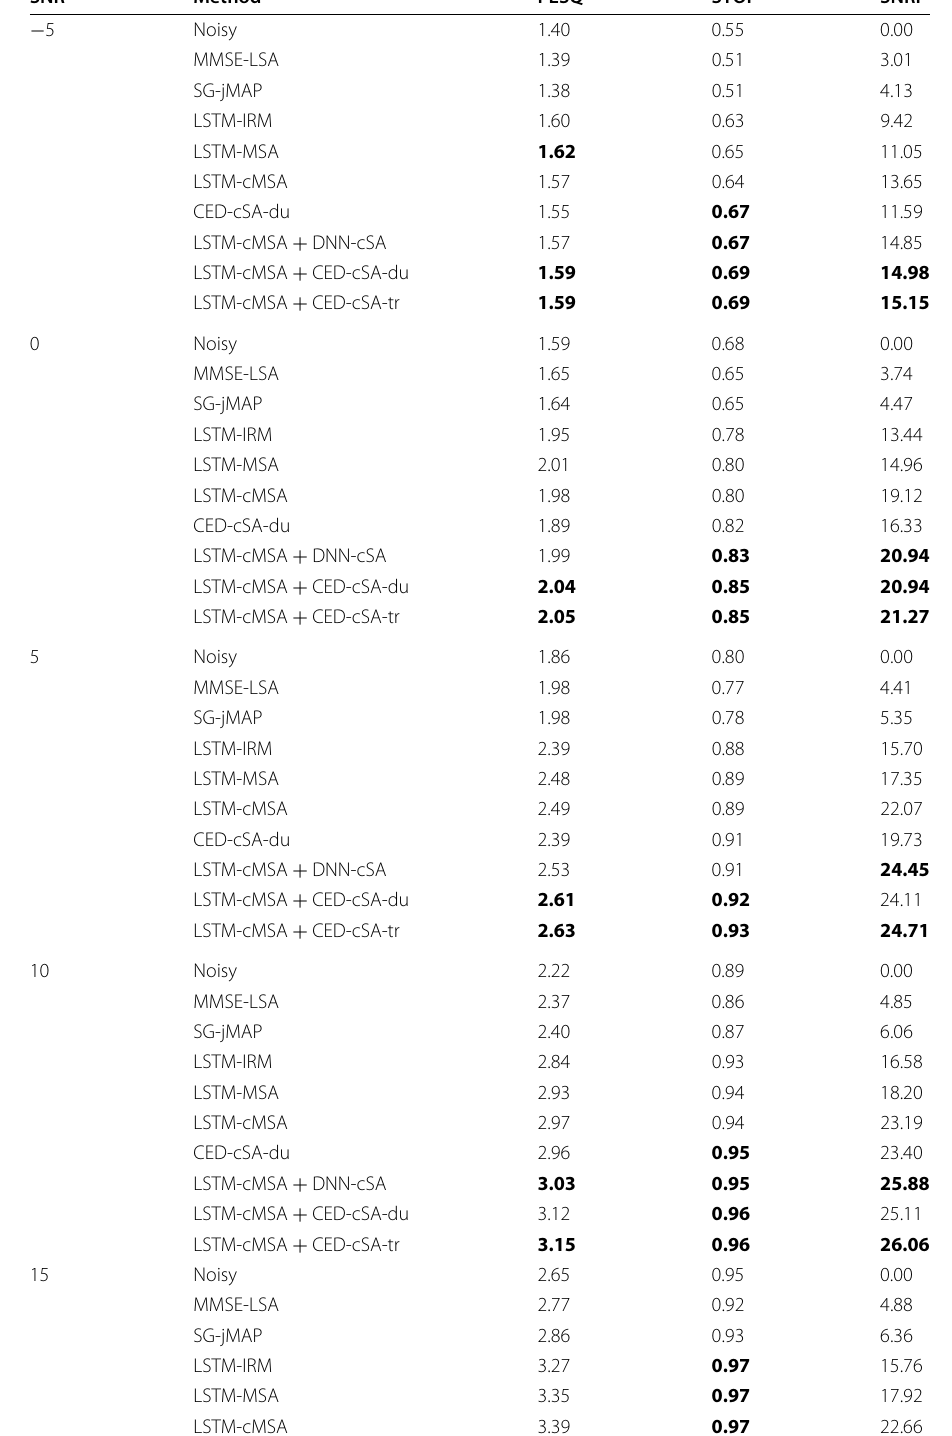
Table 3 Instrumental measures for baseline and proposed approaches averaged over unseen noise types of the test set data. Note that the SNR conditions of − 5 and 15 dB are unseen during training, whereas the remaining SNRs have been seen. Best two approaches are in boldface , high-complexity reference LSTM-cMSA+CLED-cSA-du excluded SNR Method PESQ STOI